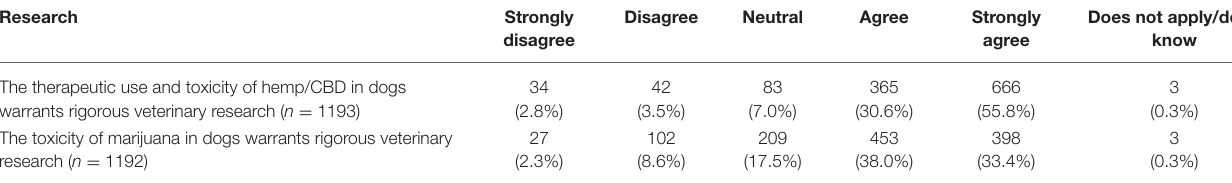
TABLE 8 | Participants’ views regarding the need for hemp/CBD/marijuana